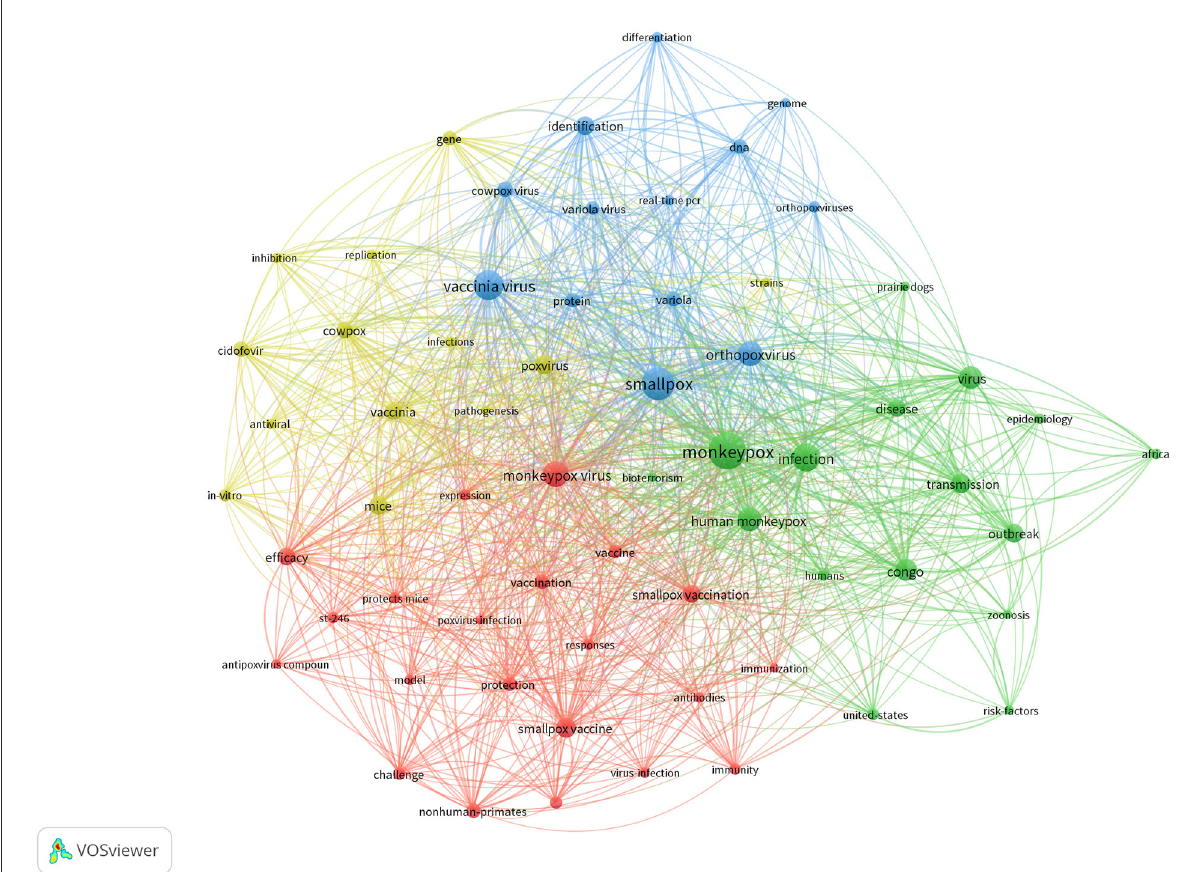
FIGURE2 Research hotspots in the field of